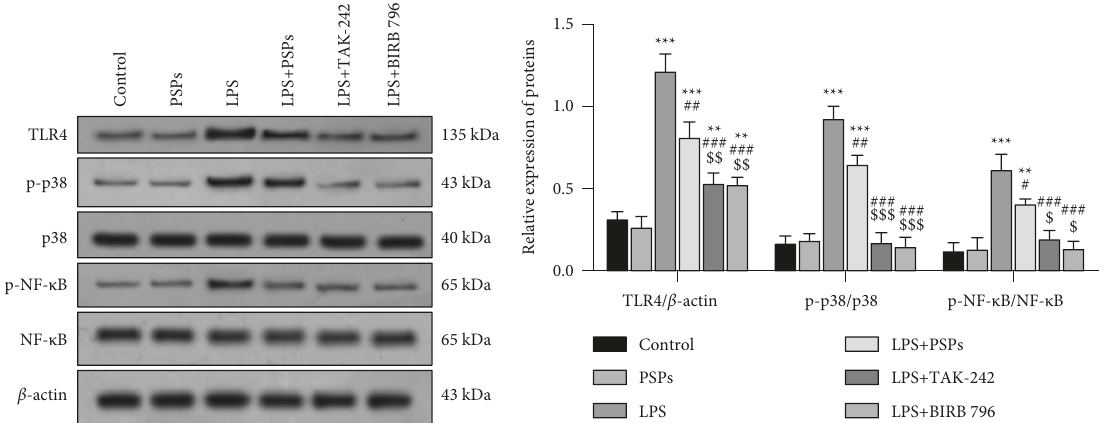
Figure 8: Verification of PSPs impact on TLR4-MAPK/NF- κ B signaling pathway. Compared with control group,